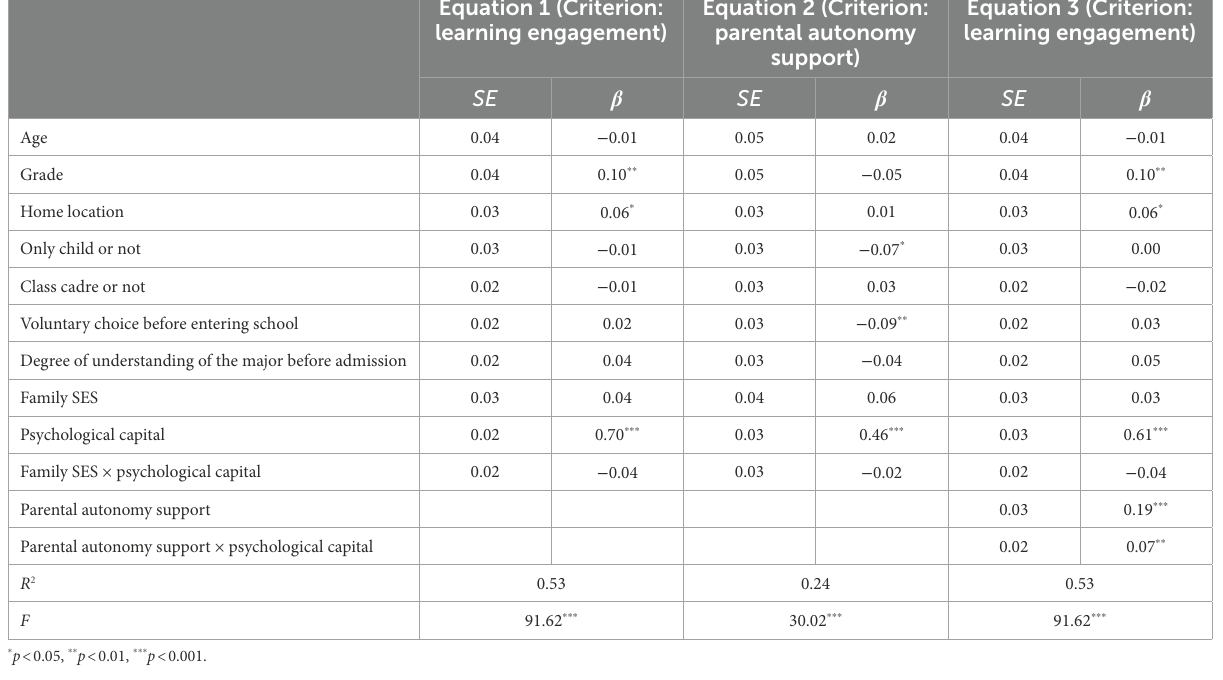
TABLE 3 A test on the moderated mediating effect of family SES on learning engagement.